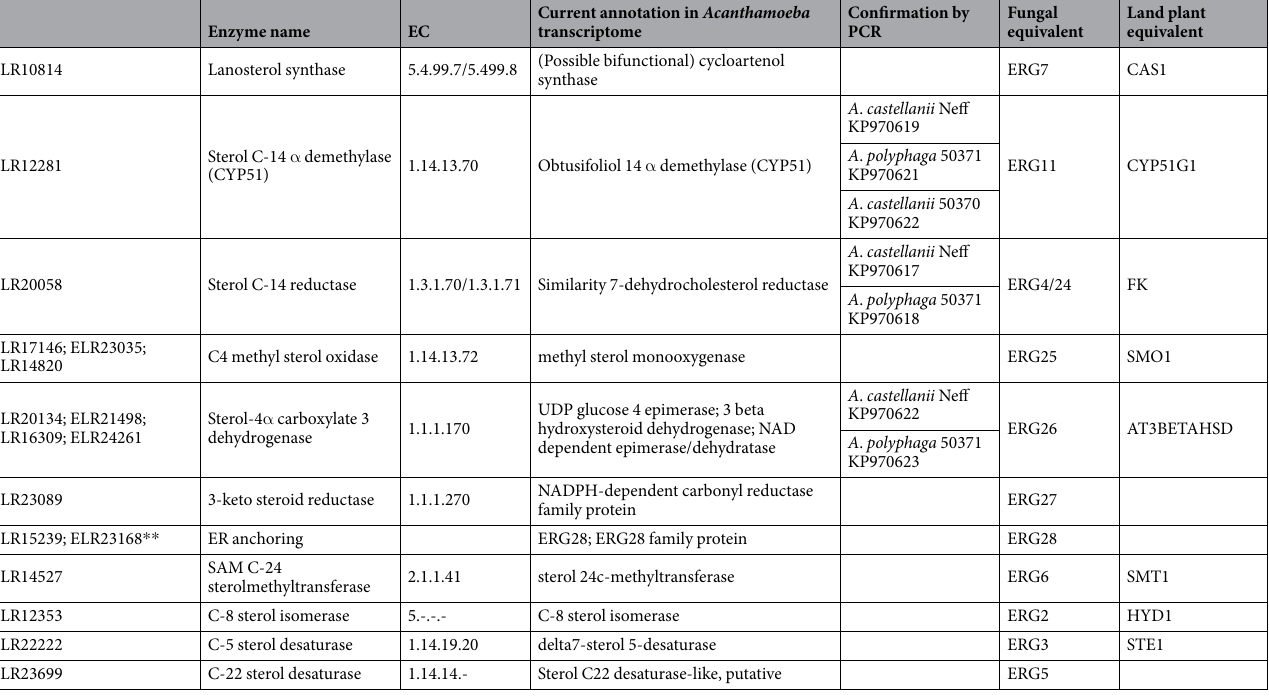
Table 1. Candidate Enzymes involved in sterol biosynthesis in Acanthamoeba